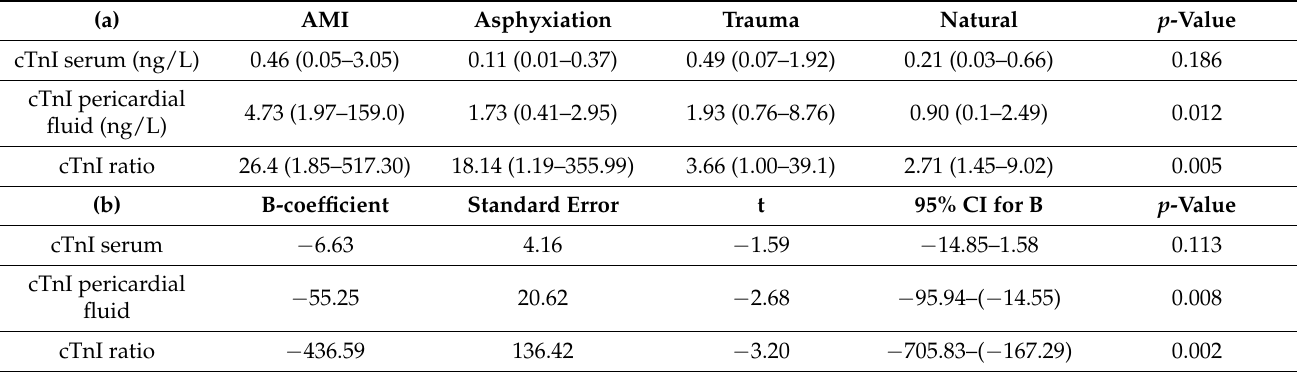
Table 2. (a) Kruskal–Wallis test comparison of cardiac troponin I (cTnI) concentrations in different causes of death and (b) association analyses of cTnI variables with the cause of death (linear regression).